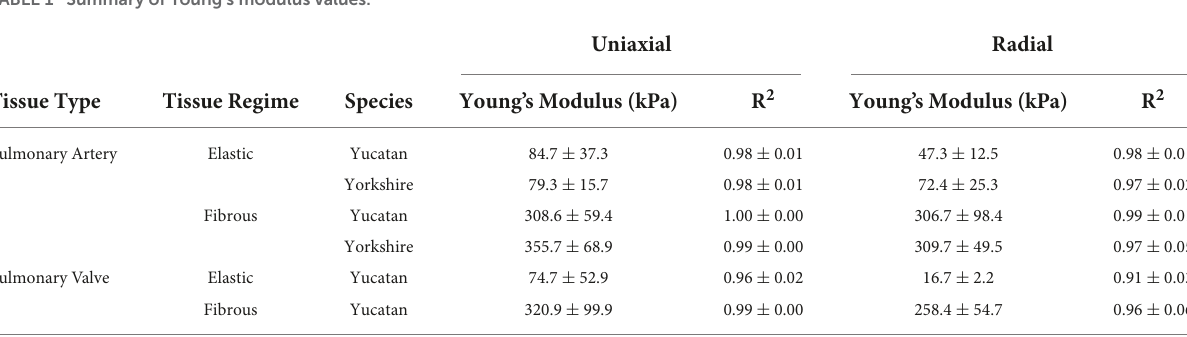
TABLE 1 Summary of Young’s modulus